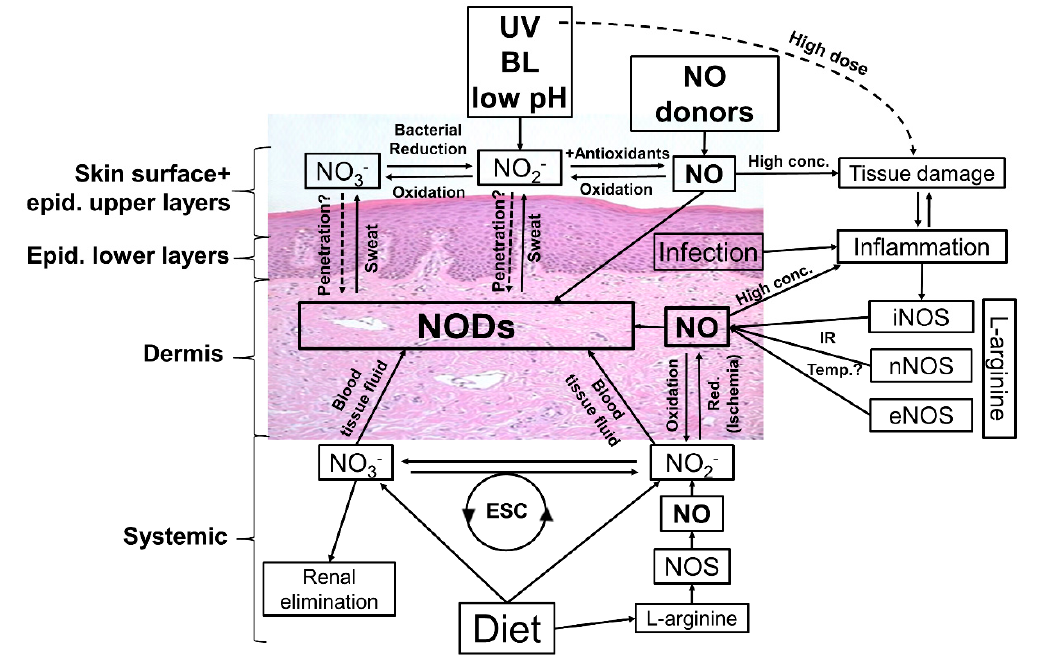
Figure 5. Possible ways to modulate the nitric oxide derivates (NODs) in the human skin. Targeting the skin there are many ways to affect the amounts and composition of NODs in skin tissues. Topical application of nitric oxide (NO) donors and nitrate (NO 3 ), nitrite (NO 2 ) +/ − acidification can increase the NOD concentrations in skin layers and eventually in underlying tissues and circulation. Irradiation with UV/UVA, or blue light (BL)-photolabile NODs found in skin, in particular nitrite, generates NO, which in turn penetrates deeper in the skin and may directly enter the circulatory system and/or react to bioactive NODs, exerting vasodilatory effects and lowering the blood pressure. By tissue damage, infection, and inflammation, the inducible NO synthase (iNOS) is activated, producing high amounts of NO via reduction of L-arginine. The generated NO reacts in the skin with biomolecules (e.g., proteins) or is oxidized to nitrite/nitrate, leading to an increase in NOD content in the skin. It seems possible to enhance the activity of iNOS and also the constitutively expressed eNOS and/or nNOS via higher temperature/infrared radiation (IR). By oral intake of nitrate/nitrite it is possible to increase, with help of the enterosalivary circle (ESC), the general amount of NODs in the human body and theoretically also the NODs in the skin. A major part of nitrate is excreted via the urine, which opens up further possibilities for influencing blood and therefore tissue concentrations of nitrate and perhaps further NODs.